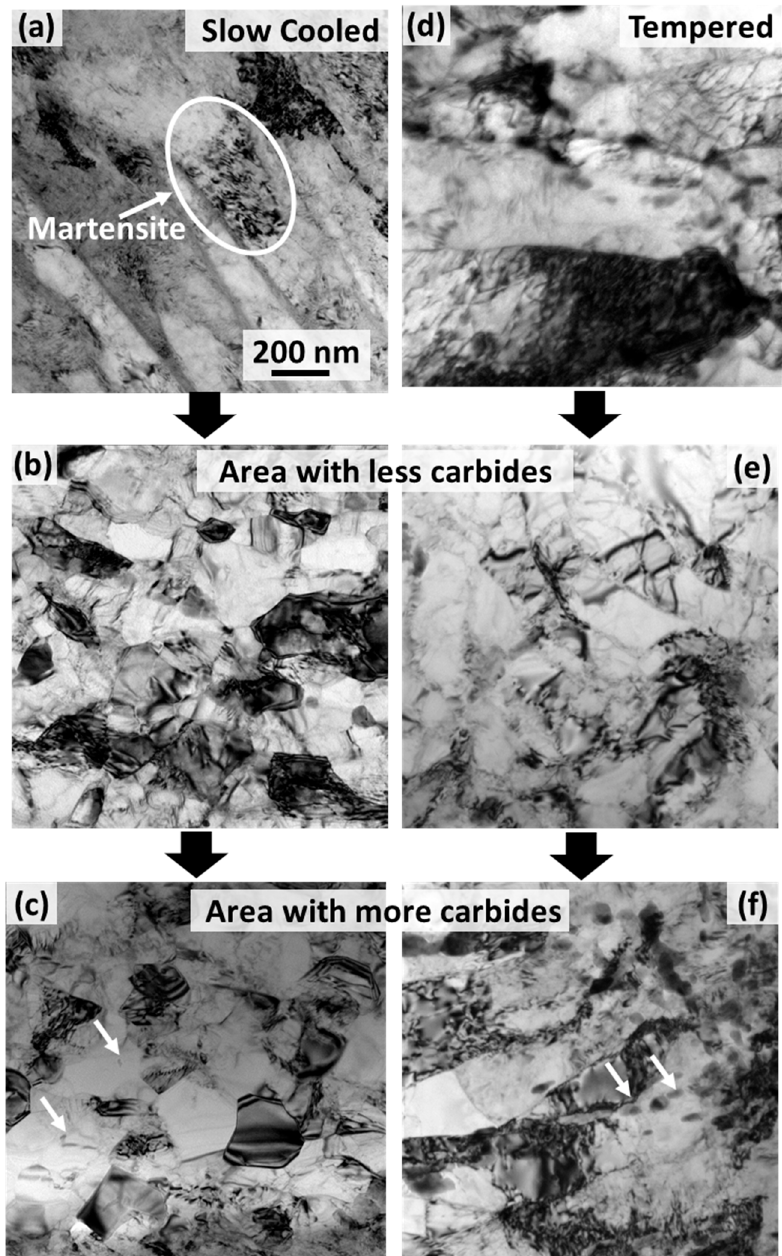
Figure 2. TEM micrographs before LSM ( a , d ) and after LSM ( b – f ): sample A showing areas without a high density of carbides ( b ) and with high density of carbides ( c ) and sample B without carbides ( e ) and with carbides ( f ). The circle in ( a ) represents a sample of martensitic microstructure in the slow cooled disc before LSM.